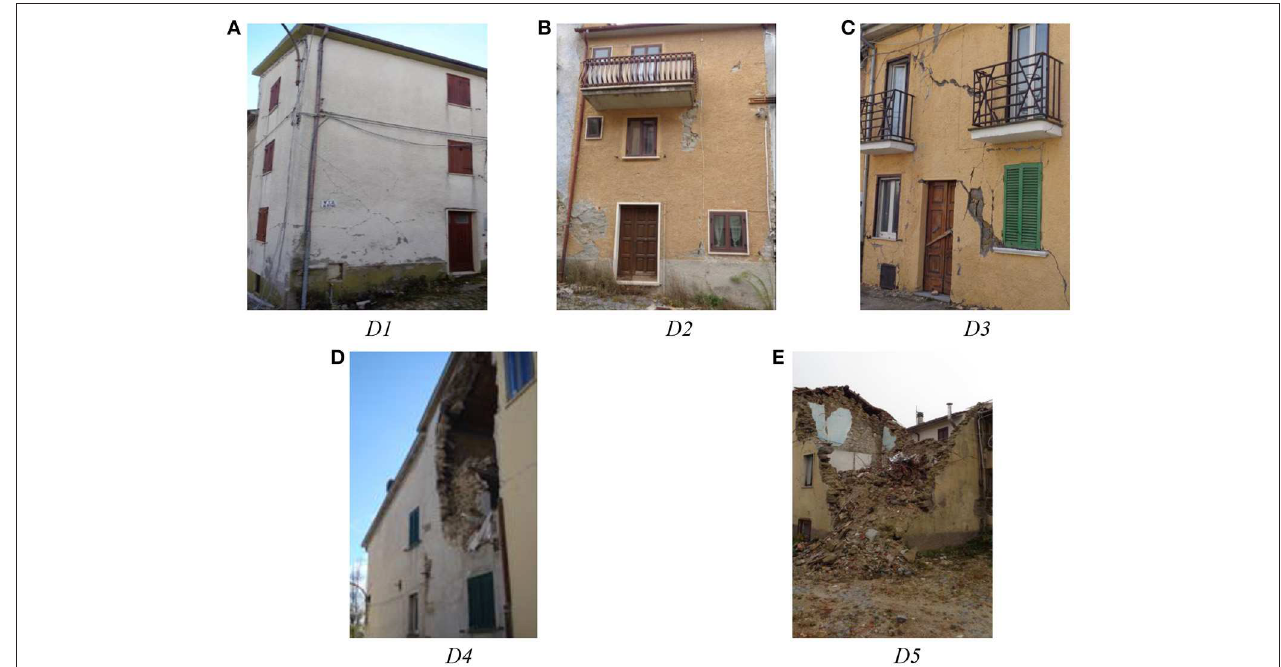
FIGURE 7 | Examples of the observed damage grades in Campotosto after the 2016 seismic event. (A) Negligible damage; (B) Moderate damage; (C) Substantial damage; (D) Serious damage; (E)